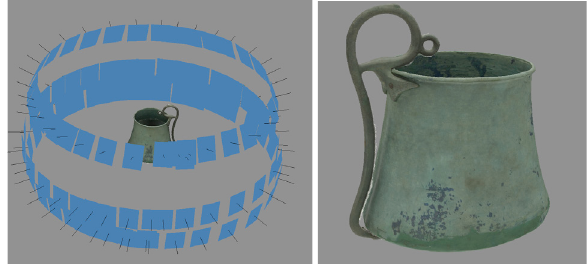
Figure 4. Photogrammetric model of a bronze jug.